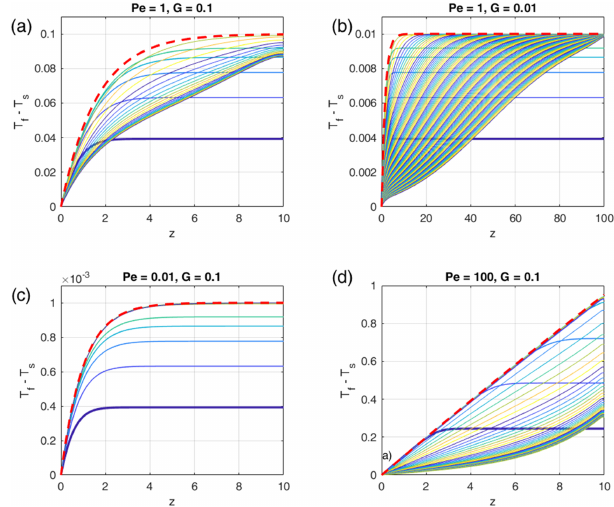
Figure 5. Comparison of depth- and time-dependent numerical so- lutions with the time-independent analytical solutions for different parameters Pe and G as indicated in the panel titles. In each panel the curves show (T f − T s ) profiles for progressive times, and the colors are cyclically varied with time from blue to yellow, starting with blue (bold curve). The bold red dashed curve shows the ana- lytical solution Eq. (22), which represents a very good estimate of the depth-dependent temporal maximum of the temperature differ- ence. In each panel the first five curves are plotted at time incre- ments of 0.5 (0.025 for Pe = 100) and the later curves with 5 (1 for Pe = 100). The total non-dimensional times of each panel are 100 (500 for G = 0 . 01). Steady state is reached in the models with G = 0 . 1. The model with G = 0 . 01 would need t = 10000 to reach steady state. The melt fraction was chosen as φ 0 = 0 .